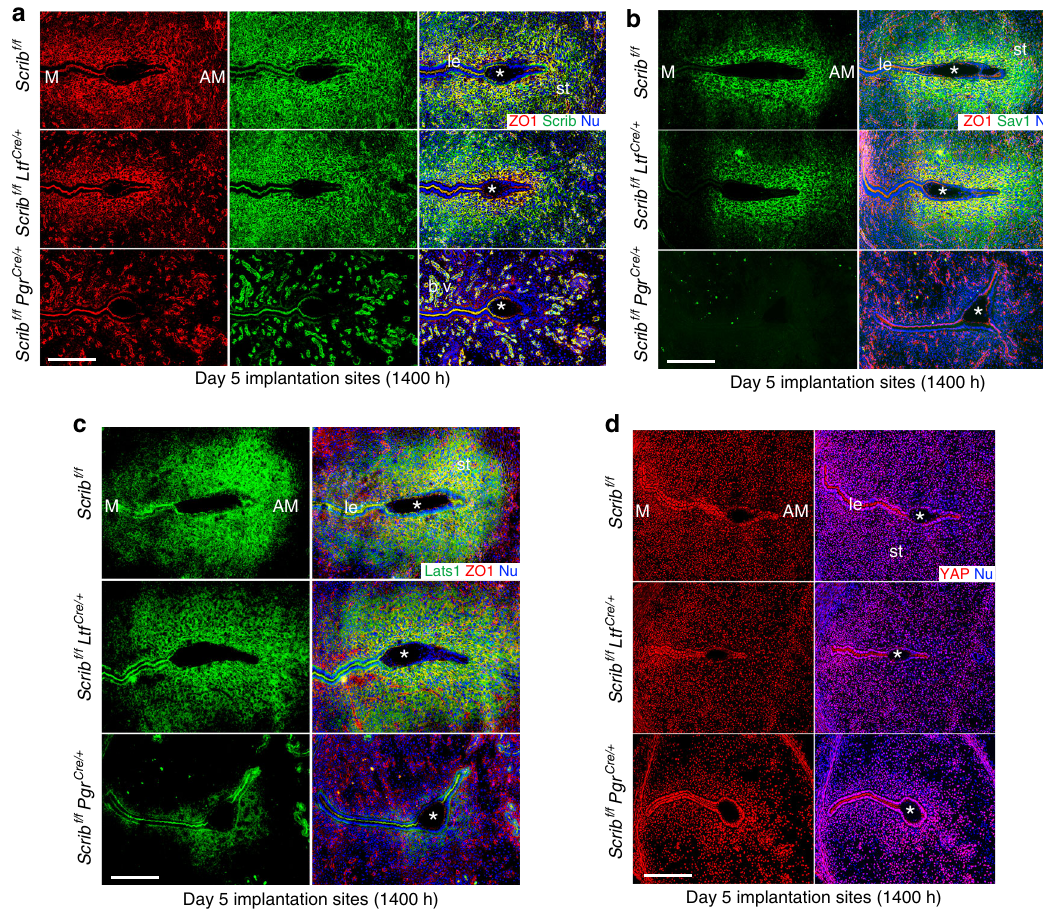
Fig. 5 On-time initiation of PDZ is derailed in Scrib f/f Pgr cre / + uteri. a IF co-localization of ZO-1 and Scrib in Scrib f/f , Scrib f/f Ltf cre/ + , and Scrib f/f Pgr cre/ + mice on day 5 afternoon (1400 h) implantation sites. PDZ represented by ZO-1 is absent in Scrib f/f Pgr cre/ + mice. b IF co-localization of Sav1 and ZO-1 in Scrib f/f , Scrib f/f Ltf cre/ + , and Scrib f/f Pgr cre/ + mice on day 5 afternoon implantation sites. Sav1 expression is absent in Scrib f/f Pgr cre/ + mice. c IF co-localization of Lats1 and ZO-1 in Scrib f/f , Scrib f/f Ltf cre/ + , and Scrib f/f Pgr cre/ + mice in day 5 afternoon implantation sites. Lats1 expression is decreased in Scrib f/f Pgr cre/ + mice. d IF of YAP in Scrib f/f , Scrib f/f Ltf cre/ + , and Scrib f/f Pgr cre/ + mice on day 5 afternoon implantation sites. Scrib f/f Pgr cre/ + implantation site shows increased levels of nuclear YAP in stroma surrounding the embryo. Scale bar: 200 μ m. Asterisks indicate the location of embryos. Each image is a representative of at least three independent experiments. M mesometrial pole, AM antimesometrial pole, le luminal epithelium, st stroma, bv blood